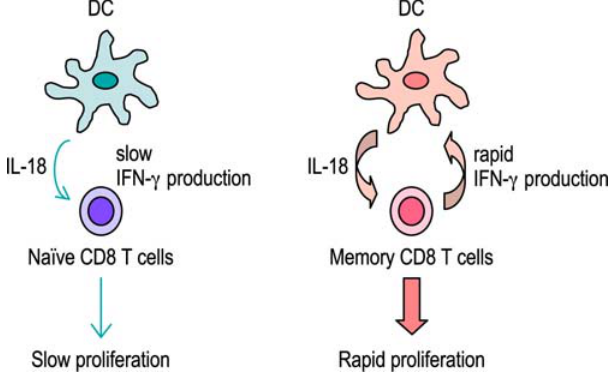
Figure 8. Model of a positive regulatory loop of IFN- c -IL-18 signaling in memory CD8 + T cell expansion. Unlike naı¨ve CD8 + T cells, memory CD8 + T cells can provide an early source of IFN- c to stimulate more IL-18 production from DCs. This positive loop of IFN- c - IL-18 signaling may play an amplifying role in the acceleration of CD8 + T cell expansion in memory response rather than in primary